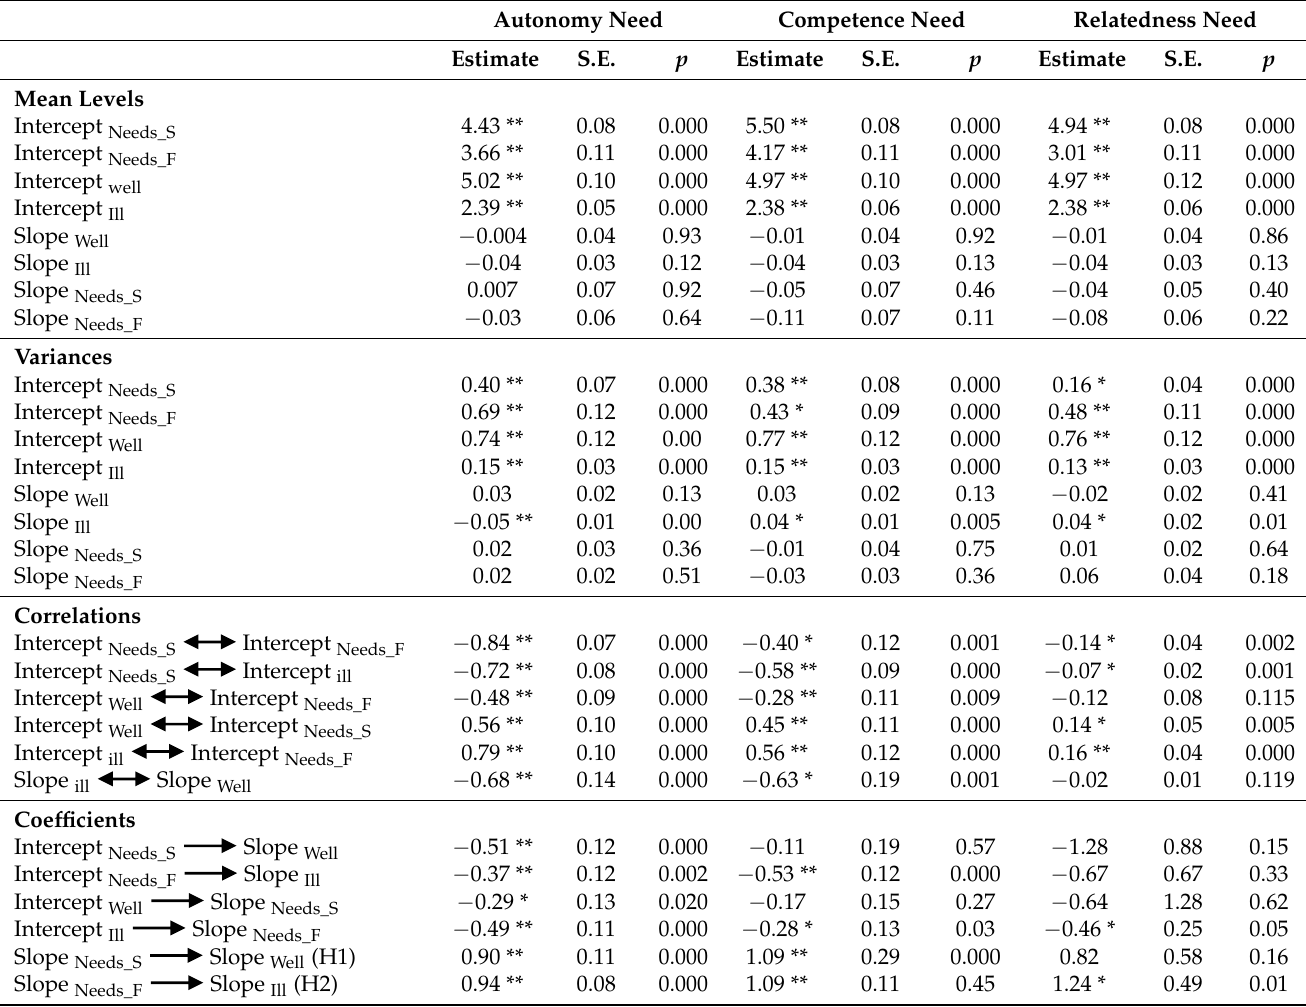
mous/Controlled Motivation . Table 5. Parameter Estimates for LGM Models: Needs Satisfaction/Frustration and Autono-